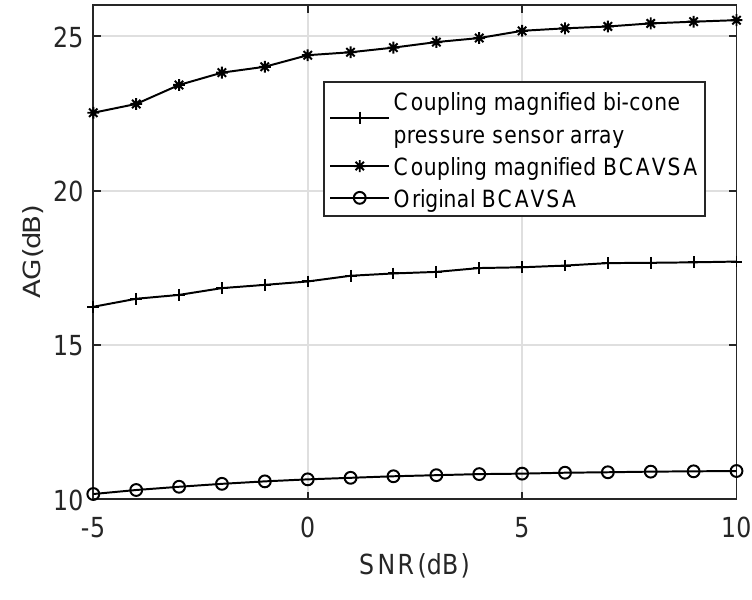
Figure 18. AG curves versus